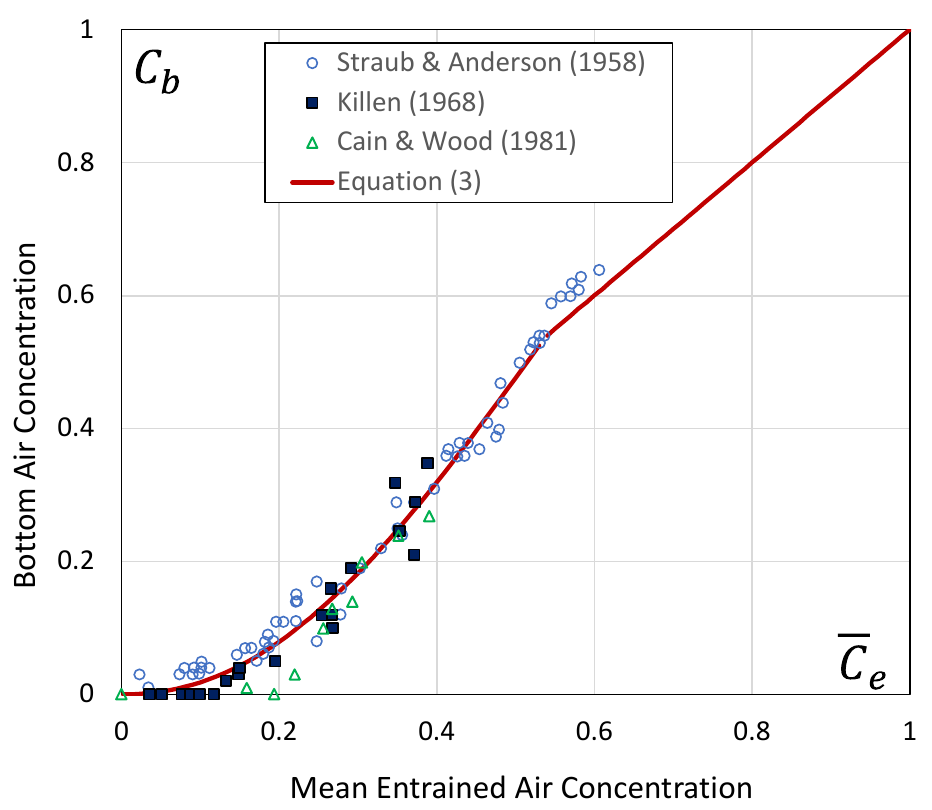
Figure 3. Equation (3) curve relating bottom air concentration to mean entrained air concentration, compared with experimental values [9,31,42].